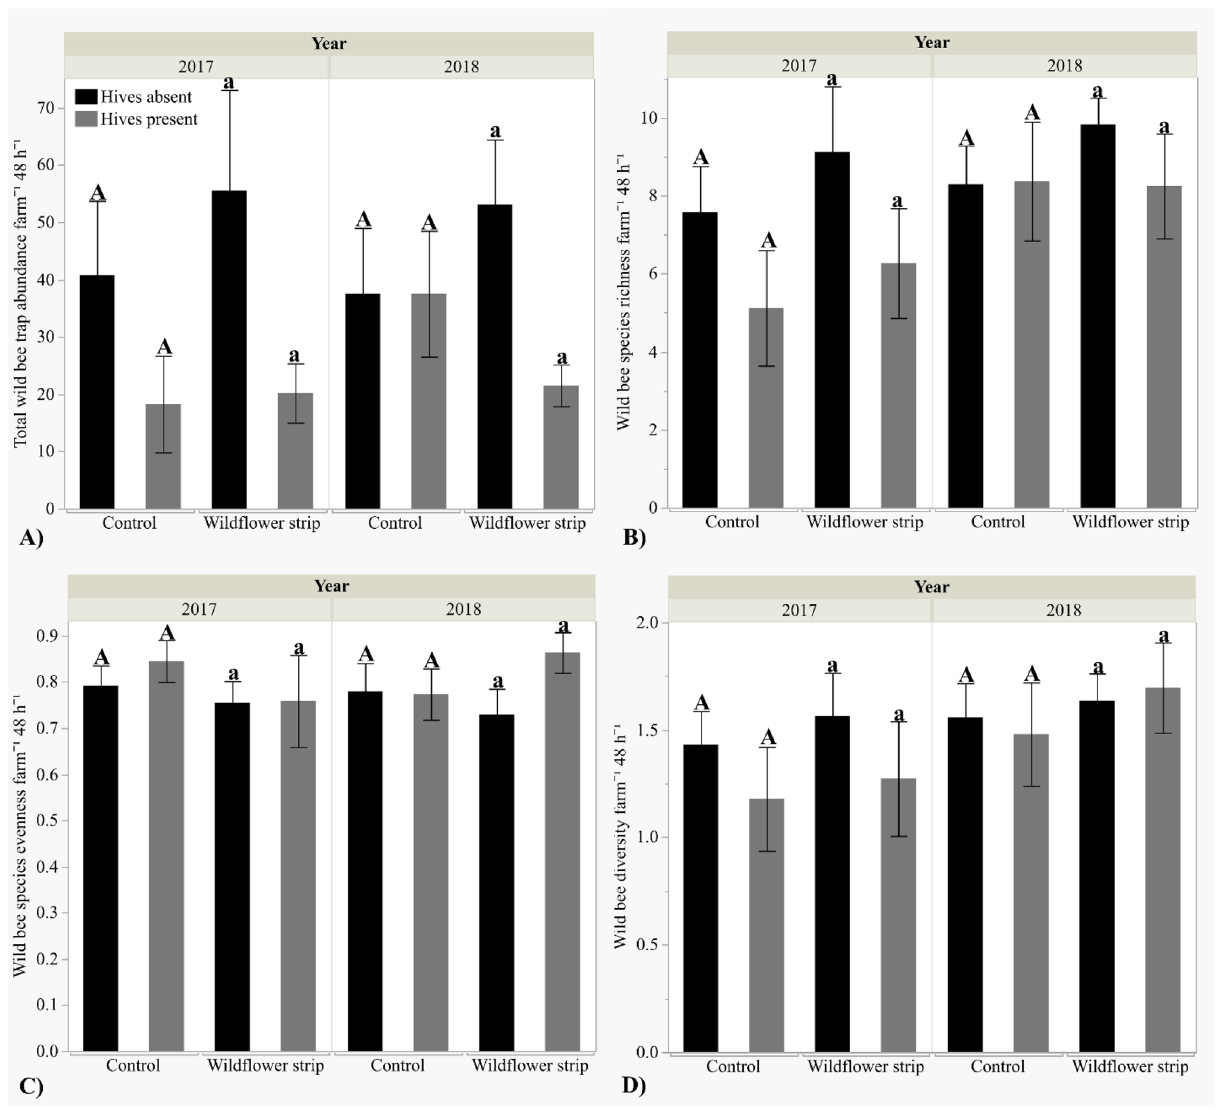
Figure 2. Mean total wild bee abundance, species richness, Shannon–Wiener diversity index, and species evenness (± SE) per farm by wildflower strip and honey bee hive presence/absence. Hive treatment means are compared within each wildflower strip treatment: the same letter indicates means are not statistically significant (α = 0.05). ( A ) Abundance, ( B ) Species richness, ( C ) Diversity, ( D ) Evenness.